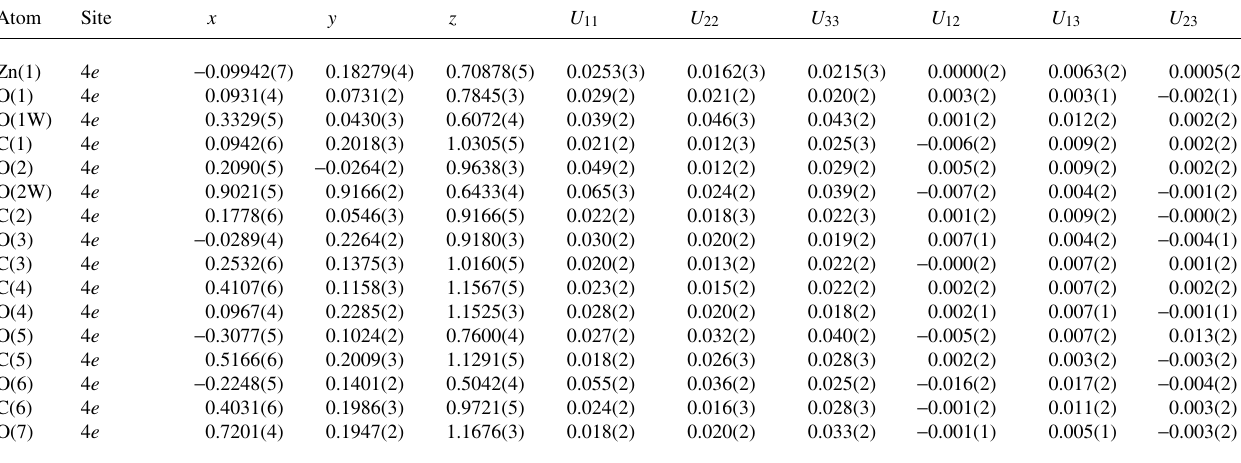
Table 3. Atomic coordinates and displacement parameters (in Å 2 ) .